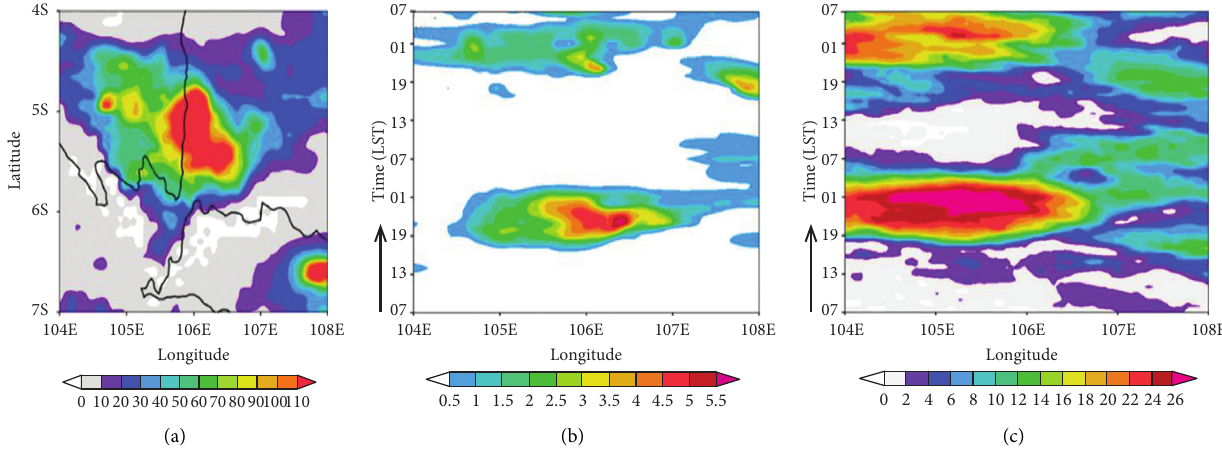
Figure 3: (a) Daily accumulation of rainfall from GSMaP on January 1-2, 2021; (b) Hovm¨oller of time-longitude cross section of rainfall from GSMaP, averaged for 5-6 ° N; (c) same as (b), but for convective index from Himawari satellite.